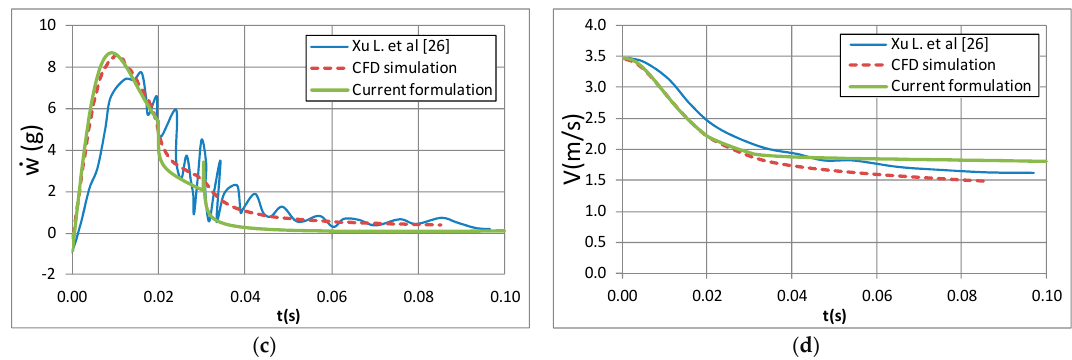
Figure 15. Free fall impact with two degrees of freedom, m = 124kg, h = 0.61 m, β = 20°, φ 0 = 5°, V cg = 0.216 m, and I xx = 8.85 kg.m 2 . ( a ) Angular acceleration during the impact. ( b ) Heel angle during the impact. ( c ) Vertical acceleration during the impact. ( d ) Vertical velocity during the impact.